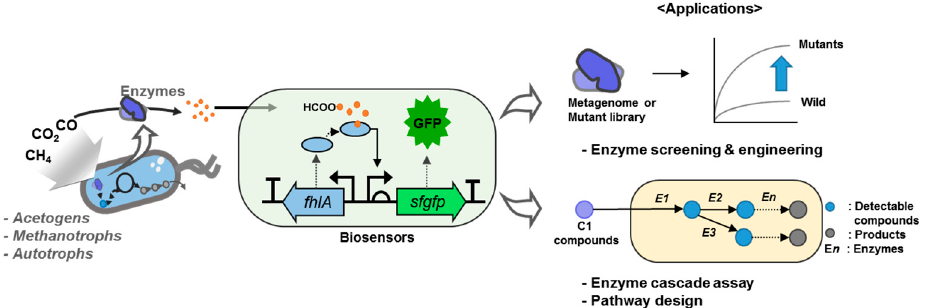
Figure 1. The importance of biosensors for enzyme screening or new pathway development in a C1 gas biorefinery. In the schematic figure of biosensor, the solid arrows and dotted arrows represent promoter and the translation of the respective genes, respectively.